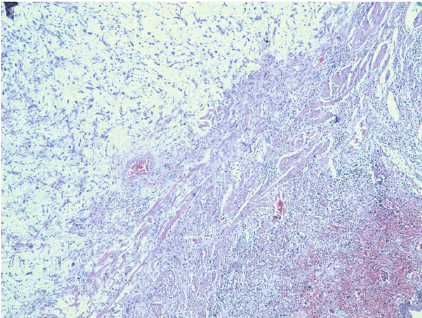
Figure 3: HESX4: sarcomatous tumoral proliferation arising from renal tissue.